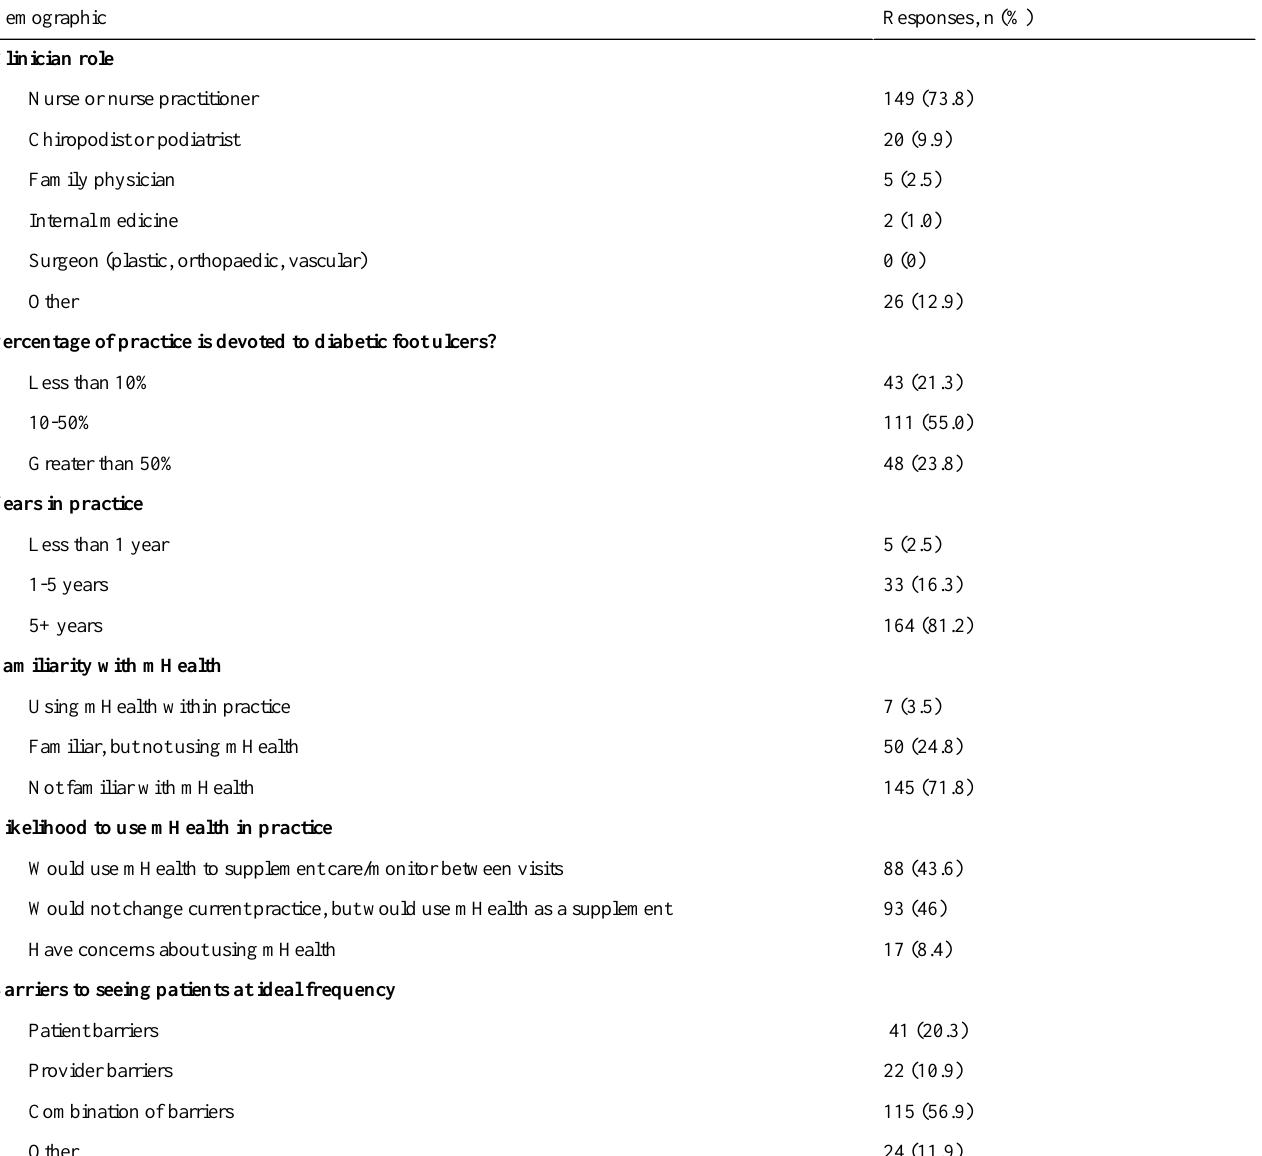
Table 2. Summary of responses by clinicians surveyed